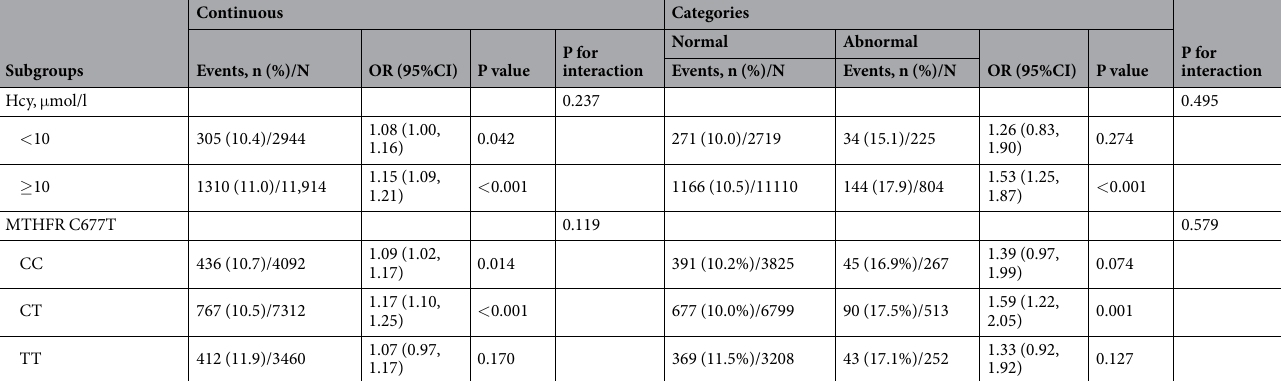
Table 6. Subgroup analysis of NOD risk associated with TG/HDL according to important covariates by logistic regression. SBP = systolic blood pressure, DBP = diastolic blood pressure, TG = triglycerides, HDL = high-density lipoprotein, TC = total cholesterol, HCY = homocysteine, NOD = new-onset diabetes, MTHFR = methylenetetrahydrofolate reductase. * Clinical center represents two rural areas in Anhui and Jiangsu provinces in China. Adjusted for age, gender, clinical center, SBP, DBP, smoking and drinking status, baseline FPG, and BMI, if not stratified. Only TG levels were analyzed because of colinearity with TC and